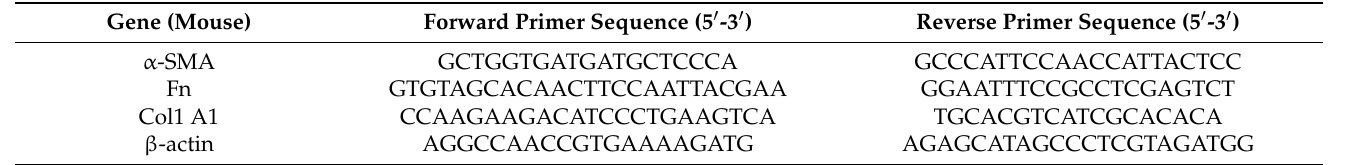
Table 2. The list of gene